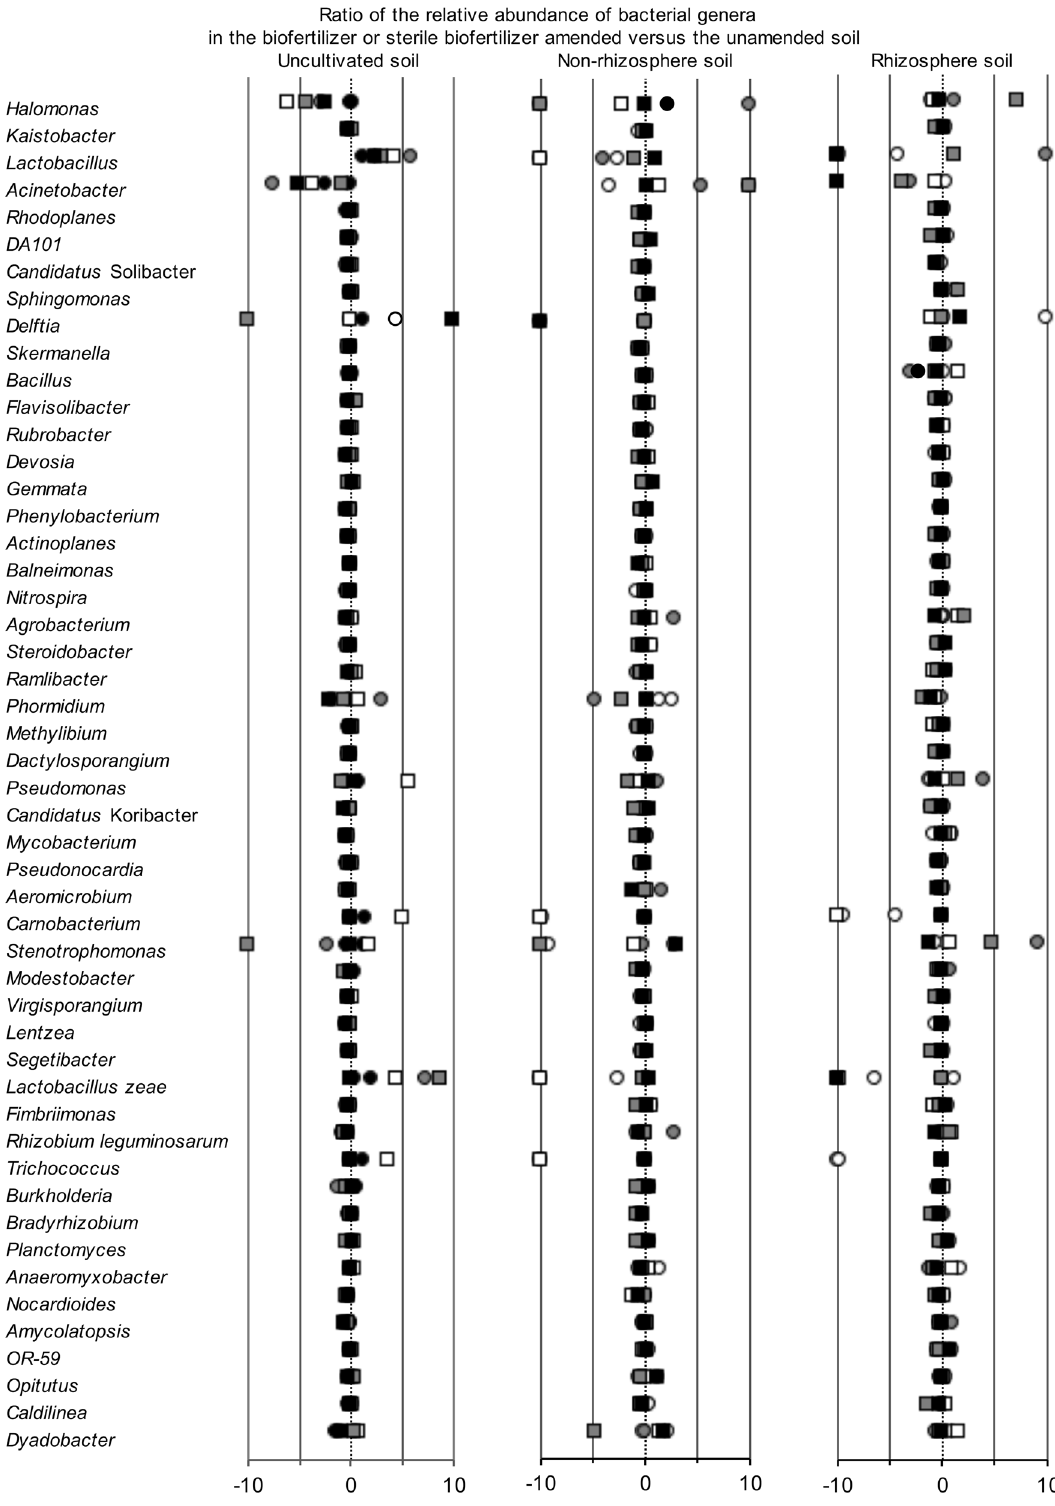
Figure 2. Ratio of the relative abundance of the 50 most abundant bacterial genera in the biofertilizer amended soil after 44 days (white circle), 89 days (grey circle) and 130 days (black circle) or amended with sterile biofertilizer after 44 days (white square), 89 days (grey square) and 130 days (black square) versus the unamended ( a ) uncultivated soil, ( b ) non-rhizosphere soil and ( c ) rhizosphere